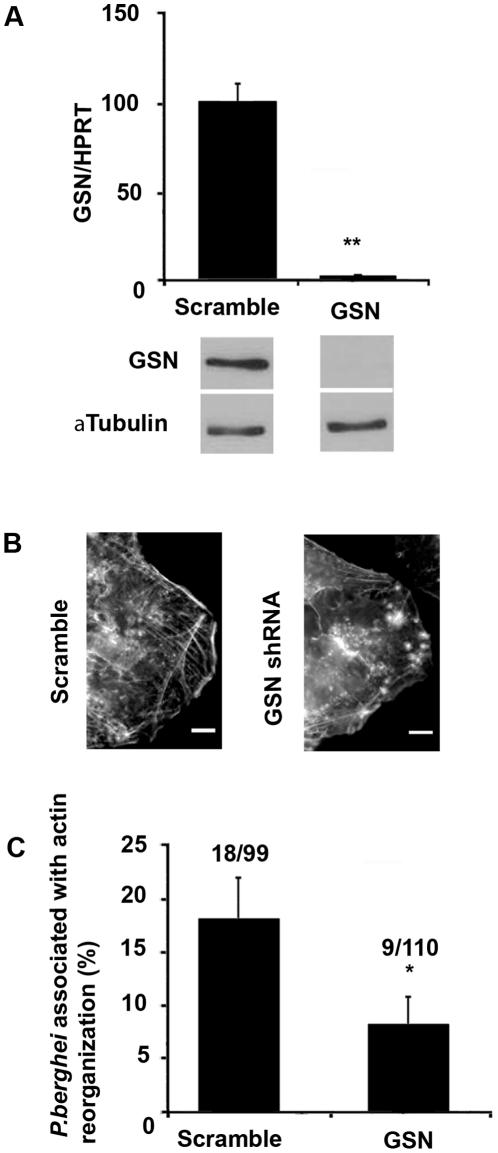
Gelsolin is important for actin reorganization around developing P. berghei and parasite disappearance.(A) GSN mRNA (top) and protein (bottom) expression after knockdown with shRNA. GSN and α-tubulin bands corresponds to 93 kDa and 55 kDa molecular weights, respectively. (B) Phalloidin staining of Huh7 cells transduced with Scramble and GSN shRNA (grey: F-actin). (C) Effect of GSN knockdown on the percentage of P. berghei parasites associated with hepatocyte actin reorganization between 10 and 16 hours p.i.. Numbers of parasites associated with actin reorganization/total numbers of parasites analysed are indicated above the bars. Error bars represent Standard Errors * p<0.05 ** p<0.01; scale bars represent 10 µm.